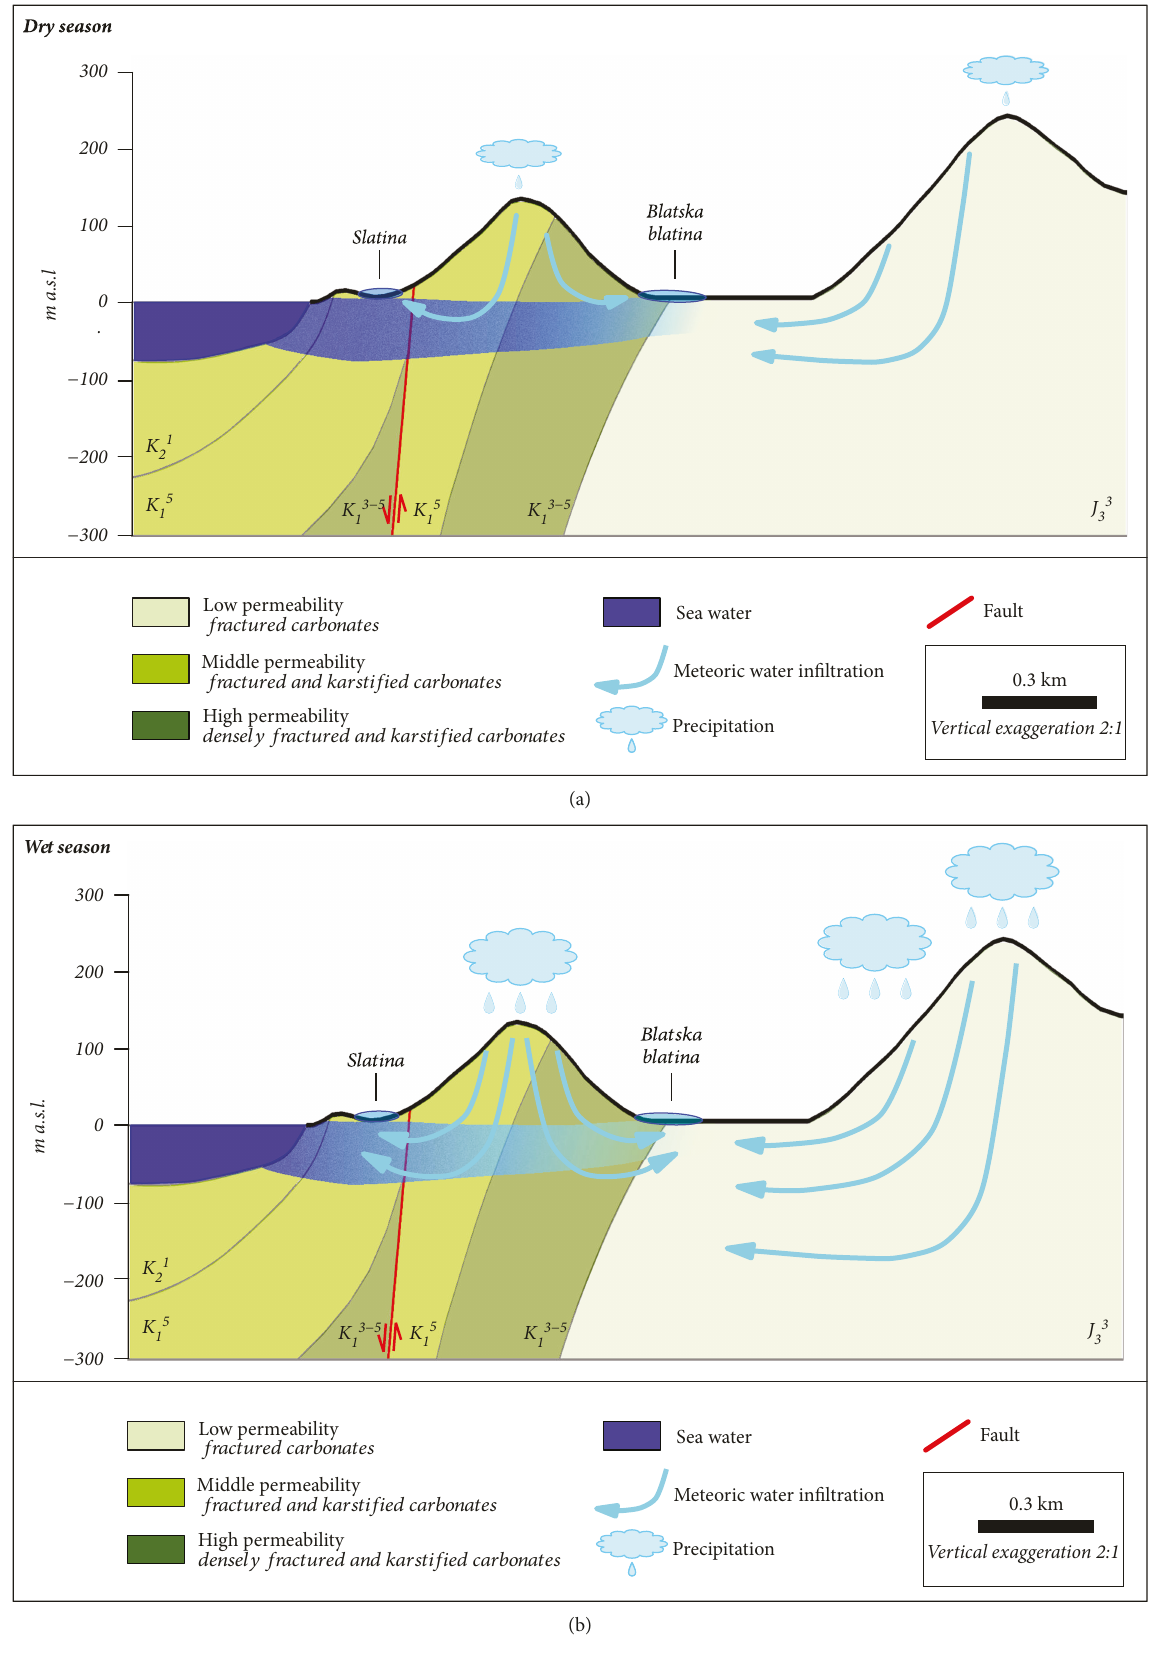
Figure 5: Conceptual models of blatinas during dry (a) and wet (b)